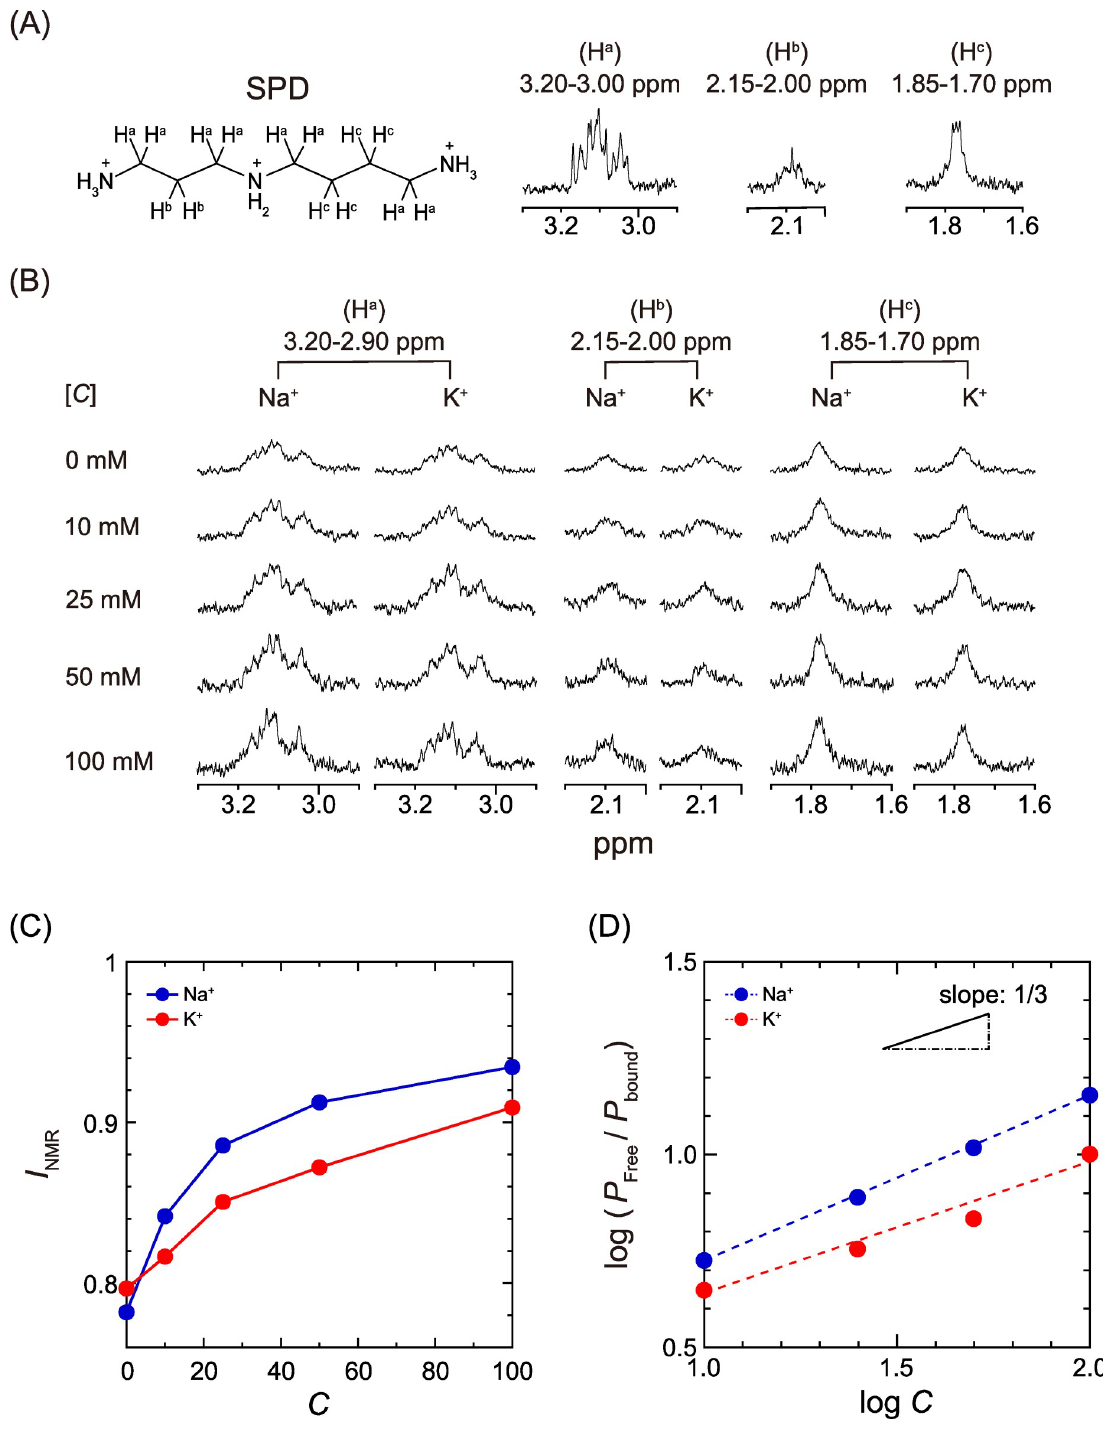
Fig 4. Evaluation of the binding affinity of Na + and K + for DNA through 1 H NMR measurements. (A) 1 H NMR signals of 0.1 mM SPD in D 2 O solution. (B) 1 H NMR signals of 0.1 mM SPD with different concentrations of Na + or K + in the presence of 1.6 mM CT DNA. (C) Changes in the integrated intensity of 1 H NMR signals, I NMR , depending on the concentrations C . The intensities in the graph were evaluated from the sum of all integrated values for the signals of SPD. (D) Log-log plot; proportion of unbound SPD to bound SPD, P Free/ P Bound , vs. the salt concentrations C . P Free and P Bound are evaluated from the relationship; P Free = I NMR and P Bound = 1 – I NMR , respectively.